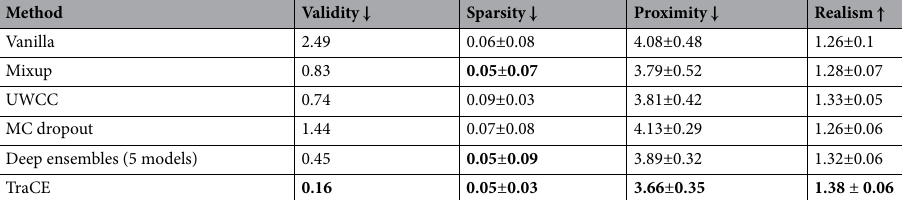
Table 2. Performance evaluation of age-based counterfactual explanations obtained using different approaches. In each case, we report results averaged across 500 test samples. Significant values are in